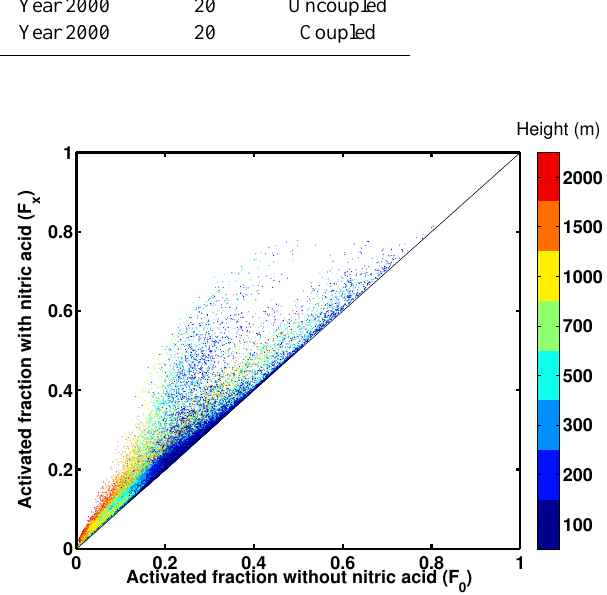
Fig. 1. Scatter plot of activated fraction with nitric acid ( F x ) plot- ted against activated fraction without nitric acid ( F 0 ) at 8 different heights. The scatter plots are generated by plotting 5-yr average ac- tivated fractions in each grid point against each other. The data is from simulations without coupling of nitric acid and cloud micro- physics (experiment HNO3 DIAG